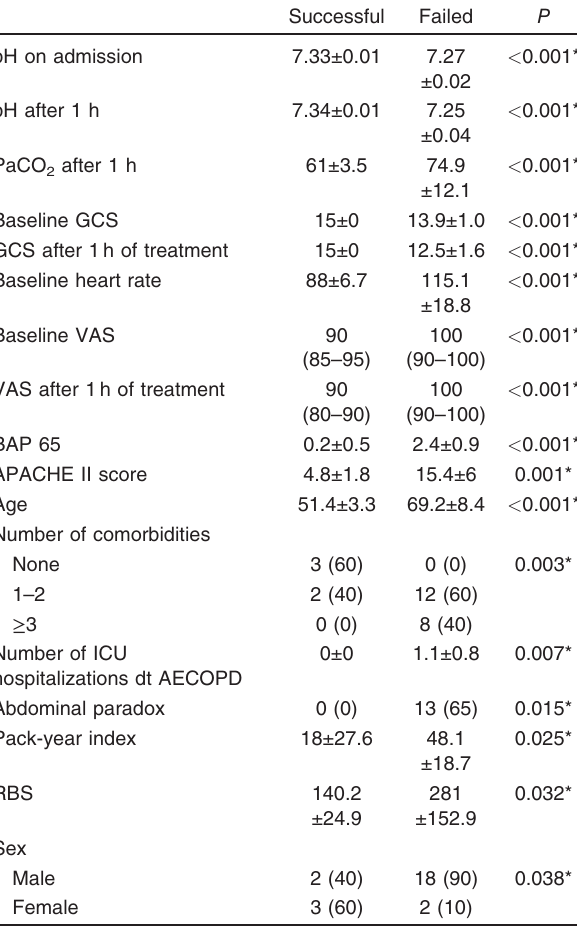
Table 14 Predictors of primary outcome for patients of group II